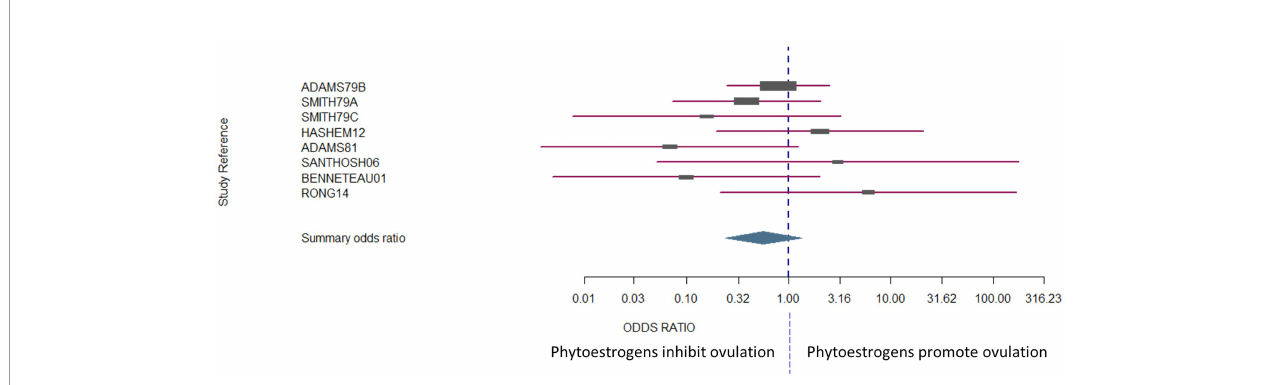
FIGURE 2 | The con fi dence interval for each study is given by a horizontal line, and the point estimate is given by a square whose height is inversely proportional to the standard error of the estimate. The summary odds ratio is represented by a diamond with horizontal limits at the con fi dence limits and width inversely proportional to its standard error (R documentation). An odds ratio higher than 1 means that the treatment is more effective than the control and vice versa (whereby 1 means null effect). In the present analysis, the positioning of the summary odds ratio shows that phytoestrogen exposure in sexually mature females